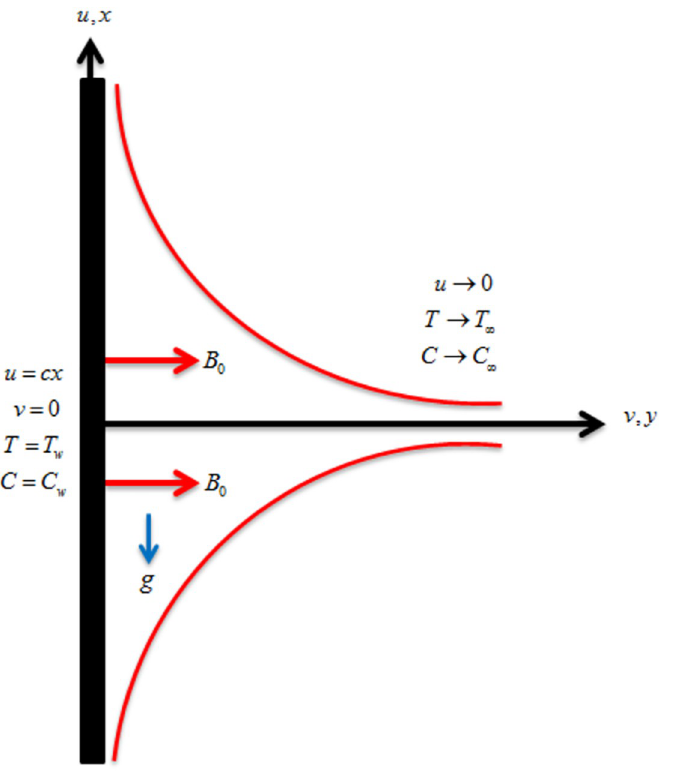
Fig 1. Geometry of the fluid